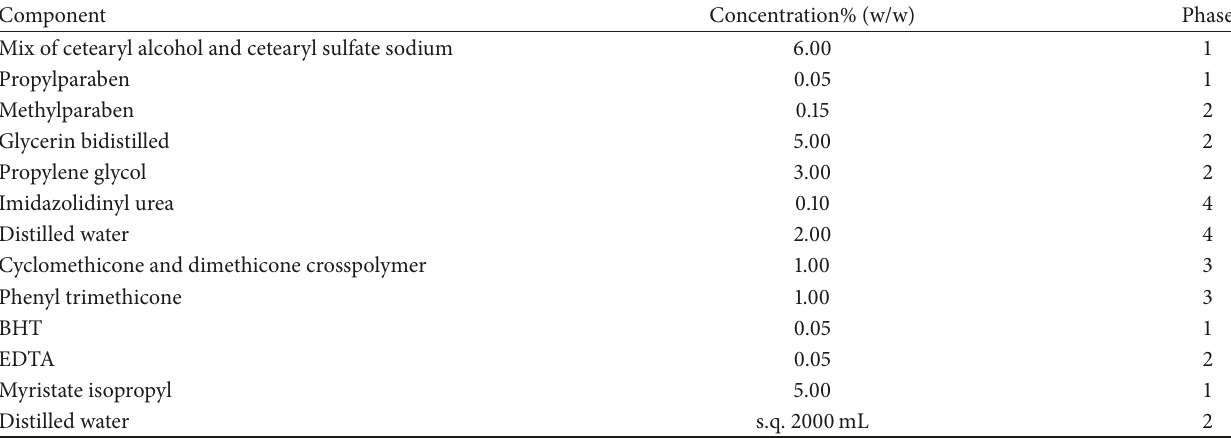
Table 1: General composition of the emulsion (emulsion base) used in the development of photoprotective formulations. Component Concentration% (w/w) Phase Mix of cetearyl alcohol and cetearyl sulfate sodium 6.00 1 Propylparaben 0.05 1 Methylparaben 0.15 2 Glycerin bidistilled 5.00 2 Propylene glycol 3.00 2 Imidazolidinyl urea 0.10 4 Distilled water 2.00 Cyclomethicone and dimethicone crosspolymer 1.00 Phenyl trimethicone BHT EDTA Myristate isopropyl Distilled water s.q. 2000 mL s.q: sufficient quantity